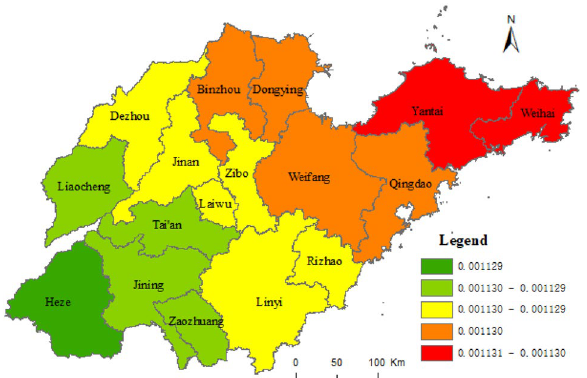
Figure 9. Coefficient of X 5 . This figure was created with ArcGIS 10.5 (URL: http:// www. esri. com/).